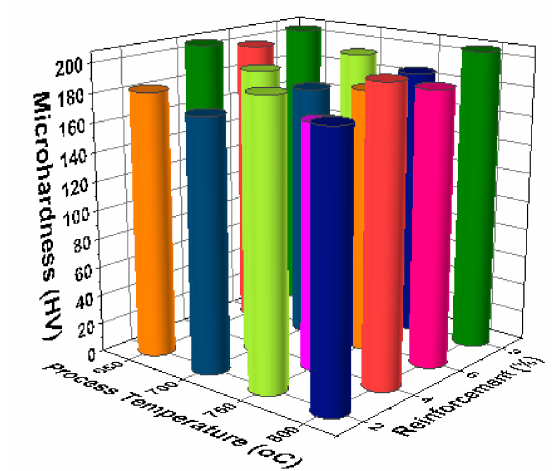
Figure 20. 3D bar plot: process temperature vs. reinforcement